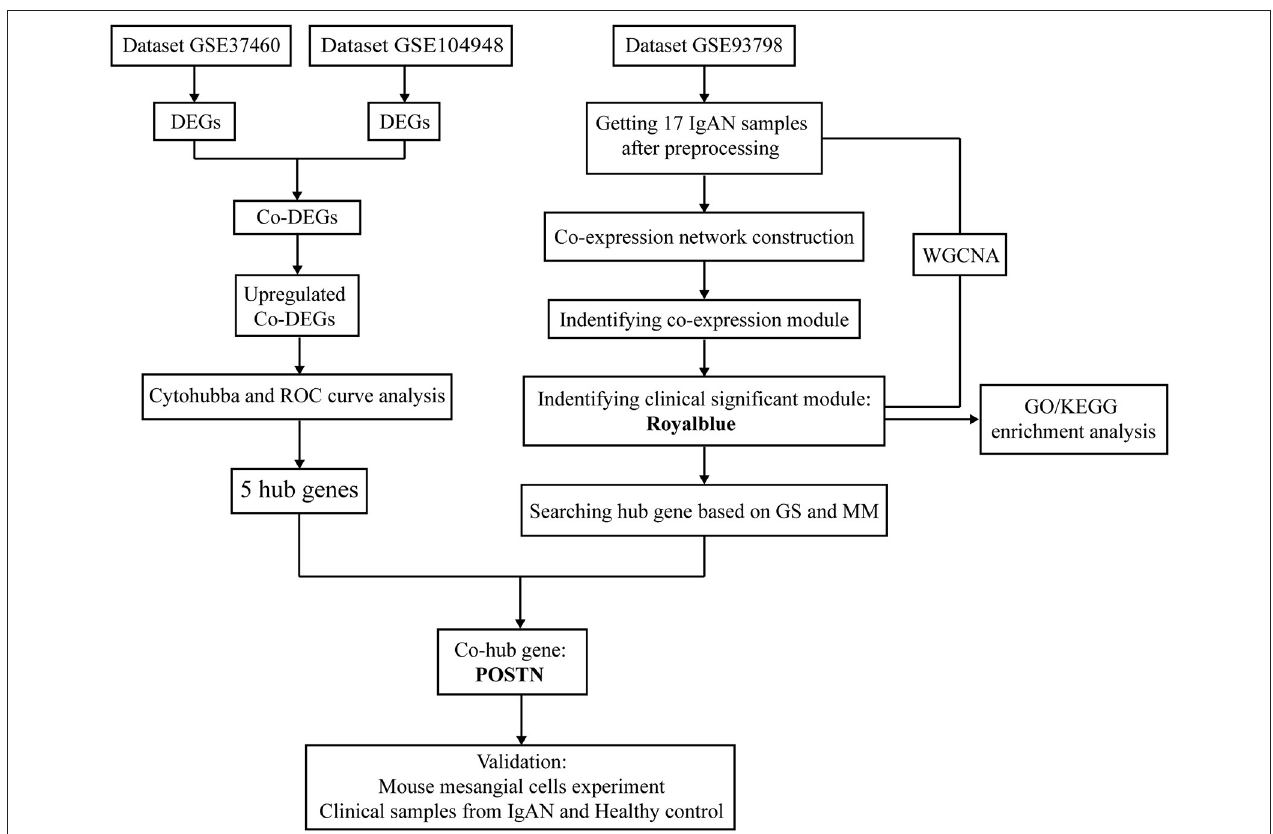
FIGURE 1 | Flow diagram of the study including data processing, analysis and experimental verification.